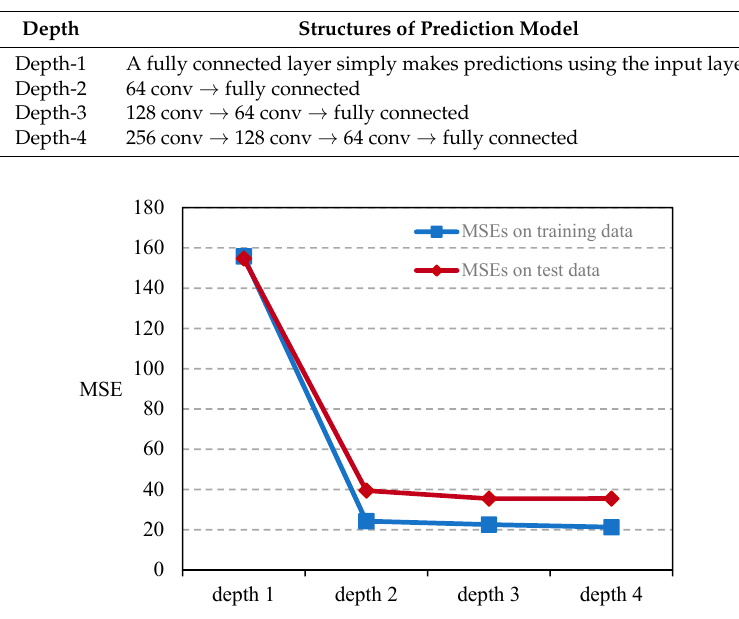
Figure 5. Results of CNN in different depths.